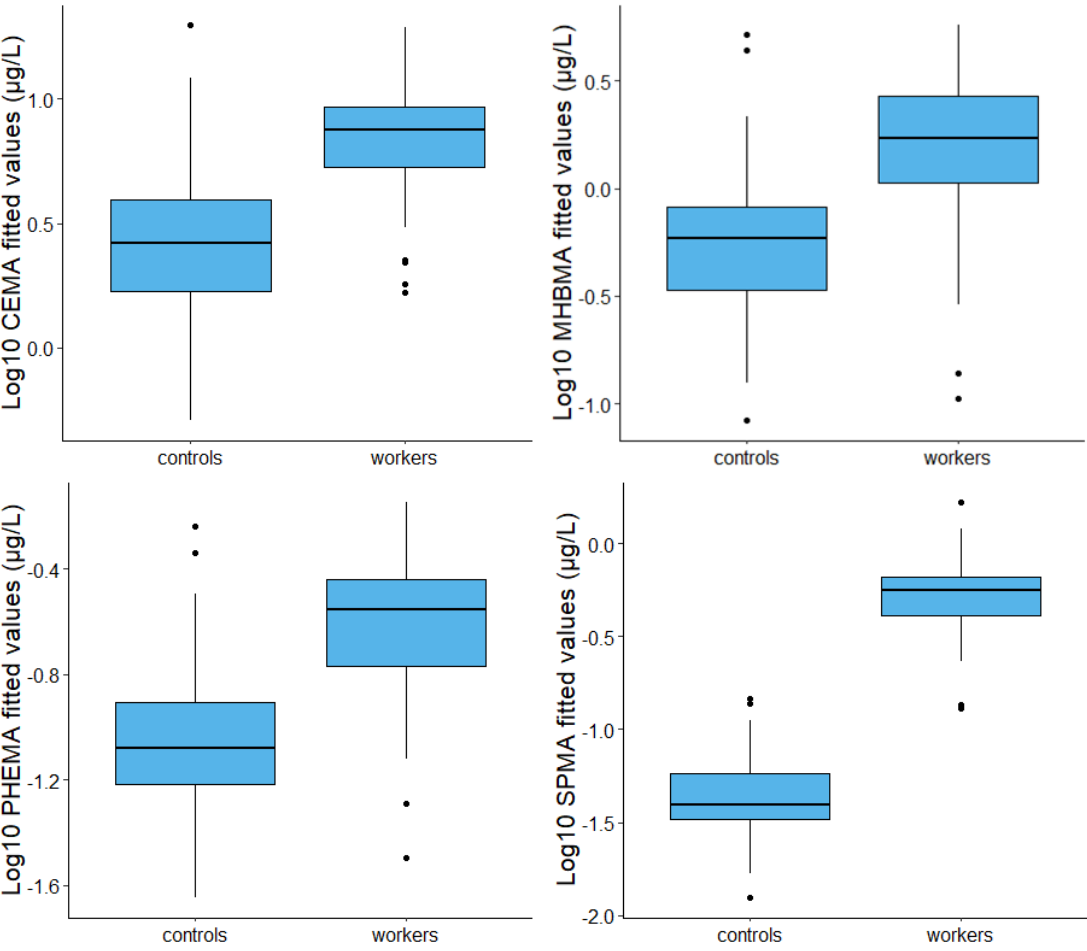
Figure 1. Box plot obtained from fitted values of linear models reported in Table 3, showing the distribution of CEMA, MHBMA, PHEMA, and SPMA in controls and coke oven workers. A box plot is a graphical representation of the data distribution. The box contains the 50% of the observations, with the median dividing the box in two areas and the upper and lower hinge representing the 25th and 75th percentile of the distribution. Outside the box, the upper whisker extends from the hinge to the highest value no further than 1.5 × interquartile range (IQR) from the hinge. The lower whisker extends from the hinge to the smallest value at most 1.5 × IQR of the hinge. Data beyond the whiskers are plotted individually and represented as dots.